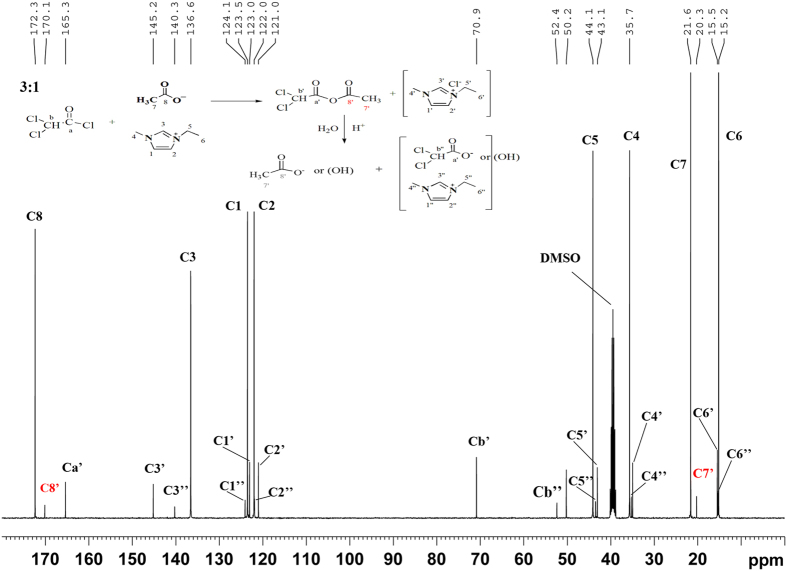
13C NMR spectra of the mixture of EmimAc/Cl2AcCl measured in DMSO-d6. (Molar radio 3:1).